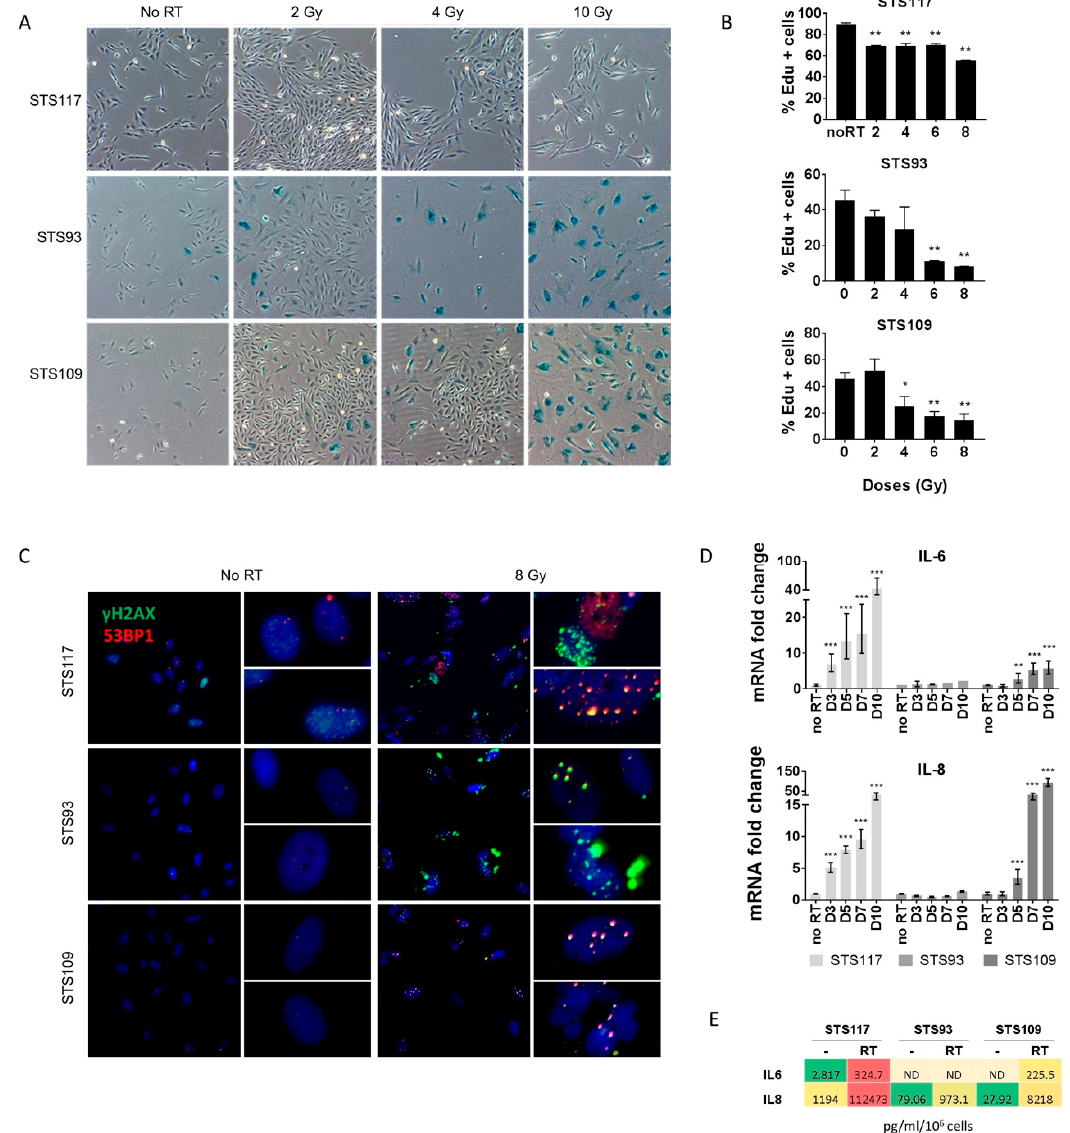
Figure 2. Radiation induces a senescence-like phenotype in sarcoma cell lines. ( A ) SA- β -gal staining 10 days following irradiation (RT) with doses of 2, 4 and 10 Gy. ( B ) Analysis of a 24 h EdU pulse labelling 5 days following radiation (2, 4, 6 or 8 Gy). ( C ) DNA damage associated γ H2AX (green) and 53BP1 (red) immunofluorescence 10 days after exposure to 8 Gy. ( D ) mRNA levels of IL-6 and IL-8 over time (D stands for day) relative to untreated controls evaluated by real-time qPCR following 8 Gy of radiation. ( E ) Secretion (pg/mL/10 6 cells) of IL-6 and IL-8 measured after 10 days (8 Gy). Not Detected (ND) indicated values below the standard curve. Data in ( B ) and ( D ) were analyzed using a two-tail Student’s t-test to compare RT treatment with the untreated control. * p < 0.05, ** p < 0.01, *** p < 0.001. Data are representative of two to three experiments. Error bars indicate ± the standard deviation.